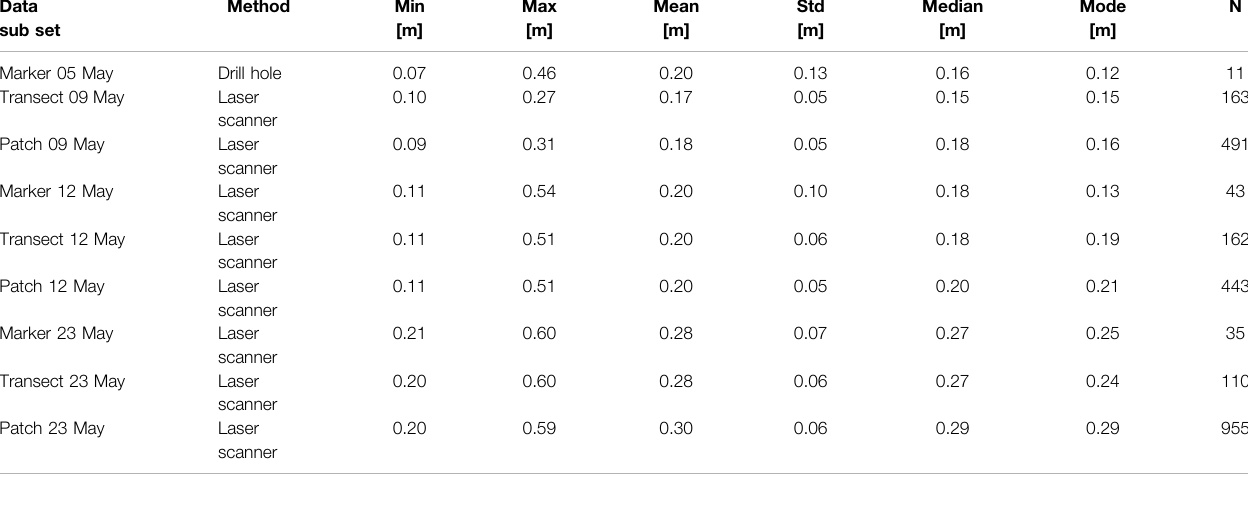
TABLE1| Snowdepthobtainedindrillholesatthemarkerlocationsandwithalaserscanner.Stdisthe fi rststandarddeviationofthemeansnowdepthandNthenumberof measurements. The modes were read from histograms with 1 cm bin width.